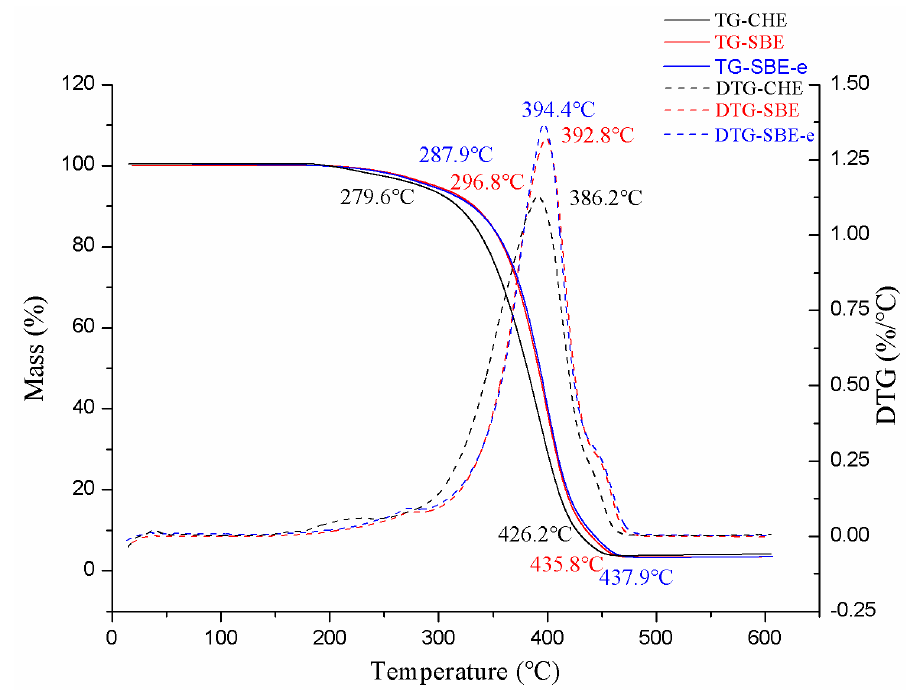
Figure 2. Thermal gravity(TG)/differential thermogravimetry (DTG) of OBO extracted by different methods.